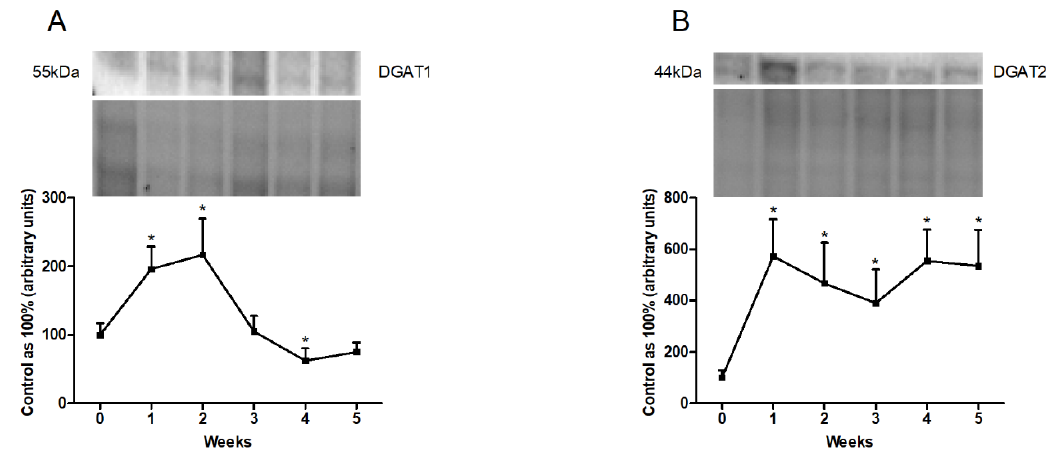
Figure 6. Representative Western blots illustrating the expression of proteins involved in lipogenesis, i.e., ( A ) diacylglycerol acyltransferase 1 (DGAT1) and ( B ) diacylglycerol acyltransferase 2 (DGAT2) in